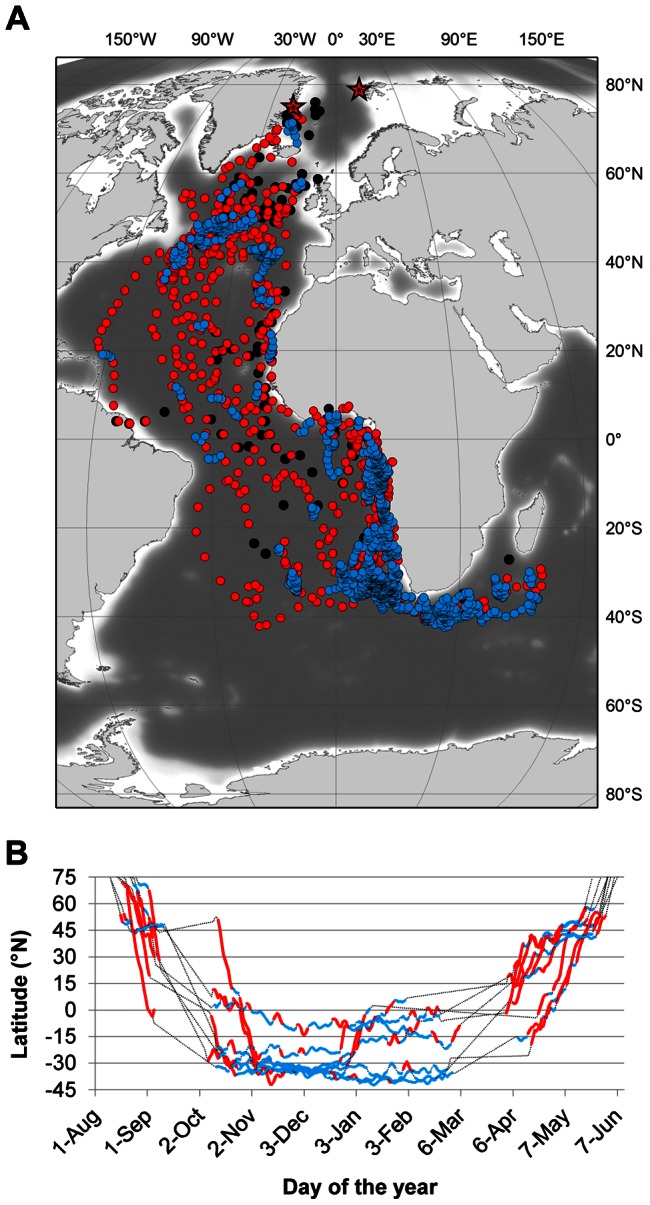
Staging areas (blue lines and symbols) used by Long-tailed Skuas.(a) geographical distribution of the staging areas used in the Atlantic and Indian Oceans; red colour is used for migration (i.e. “non-staging”) periods, blue colour for staging and black for periods when status could not be defined (i.e. when less than three successive days with daily positions). (b) individual differences in timing and latitude of staging.